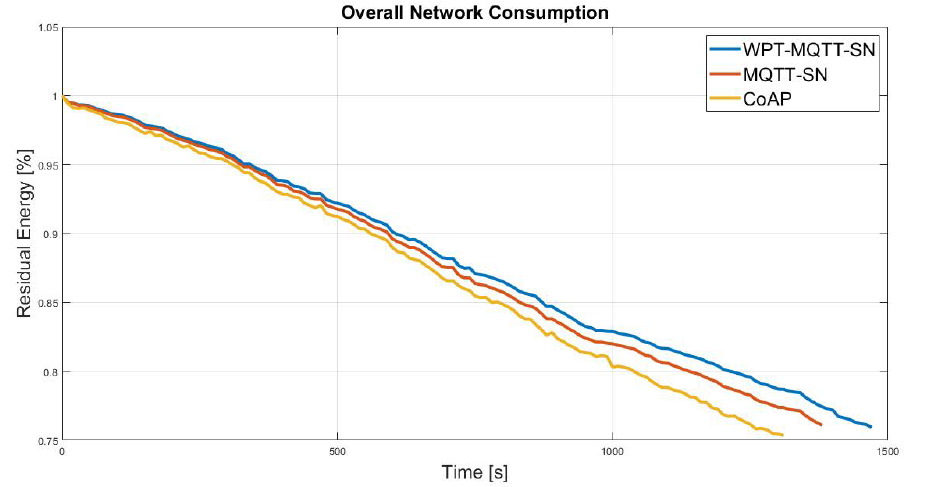
Figure 7. Normalised average residual battery level achieved by the CoAP, MQTT-SN and WPT- MQTT-SN protocols in a Balanced Random Mesh topology nodes